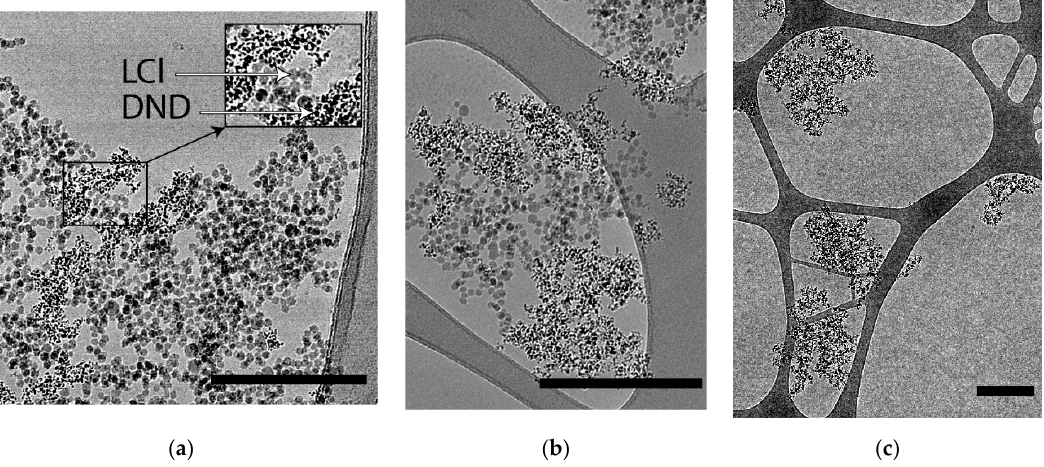
Figure 2. Cryo-TEM images of the aggregates in LCl/DND mixture with DND content 12.5 wt.% ( a ) and 80 wt.% ( b , c ). The arrows ( a ) indicate LCl and DND particles. Scale bars are 400 nm ( a , b ) and 1 µ m ( c ). Table 1. The parameters for the particle pair interaction energy evaluation.